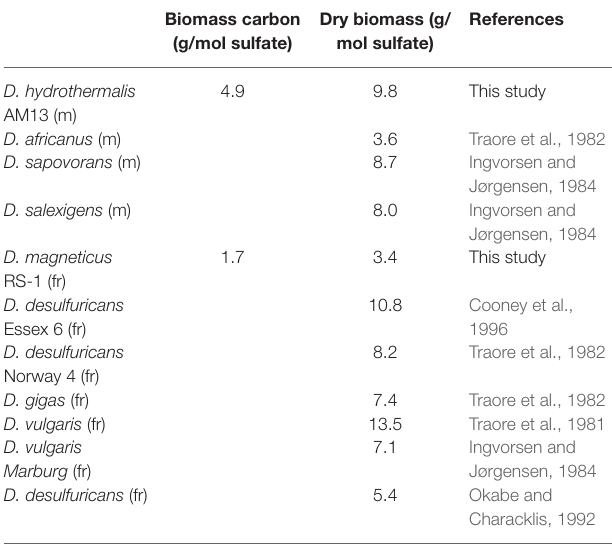
TABLE 4 | Estimated biomass carbon and dry biomass yields of Desulfovibrio hydrothermalis AM13 and Desulfovibrio magneticus RS-1 grown with sulfate and